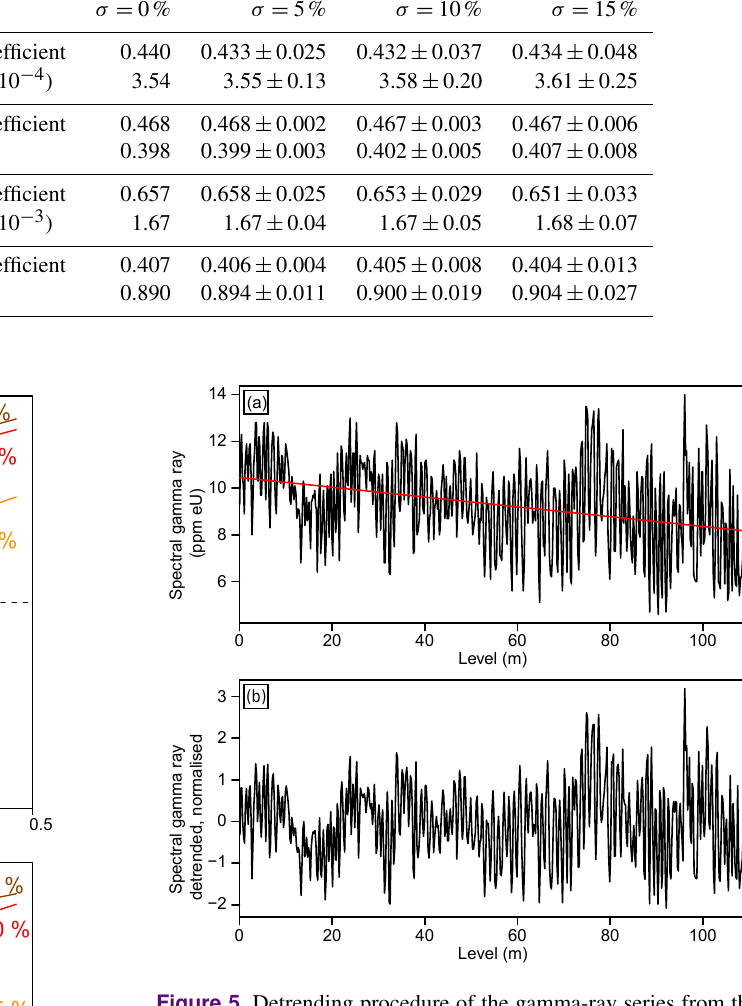
Figure 5. Detrending procedure of the gamma-ray series from the La Charce section. (a) Raw gamma-ray signal (black curve) with best-fit linear trend (red curve). (b) Gamma-ray series after subtrac- tion of the linear trend and standardisation (average = 0; standard deviation =